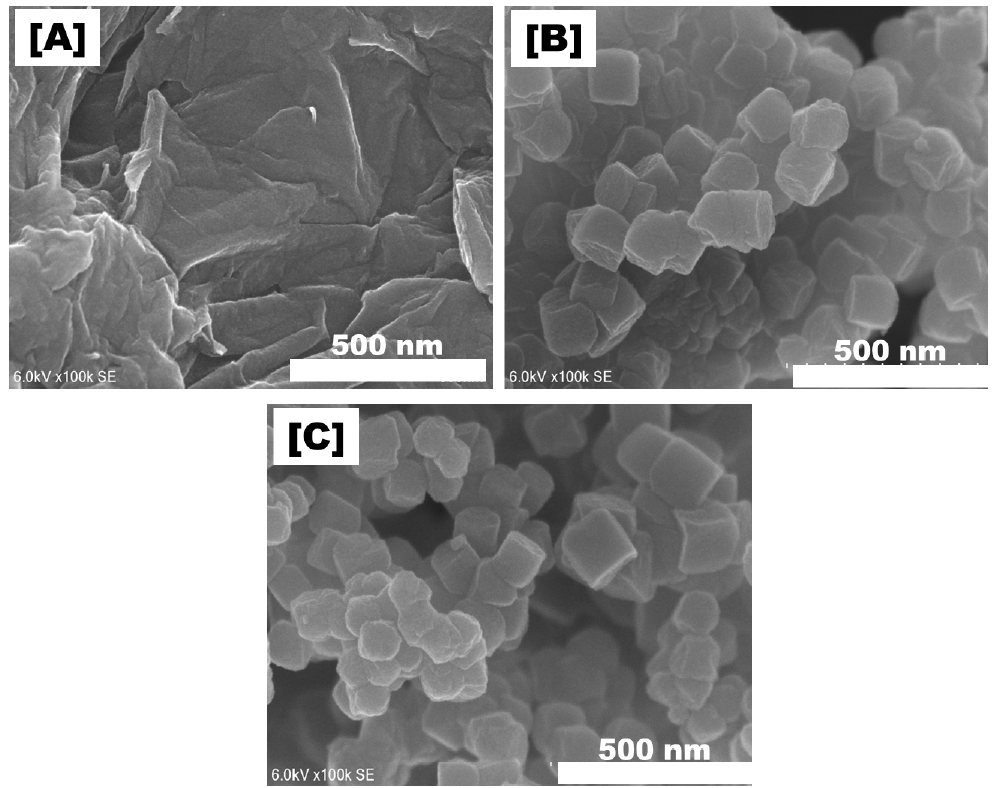
Figure 1. Scanning electron microscope (SEM) images of ( A ) graphene oxide (GO), ( B ) metal organic framework (UiO ‐ 66), and ( C ) the UiO ‐ 66_GO composite.